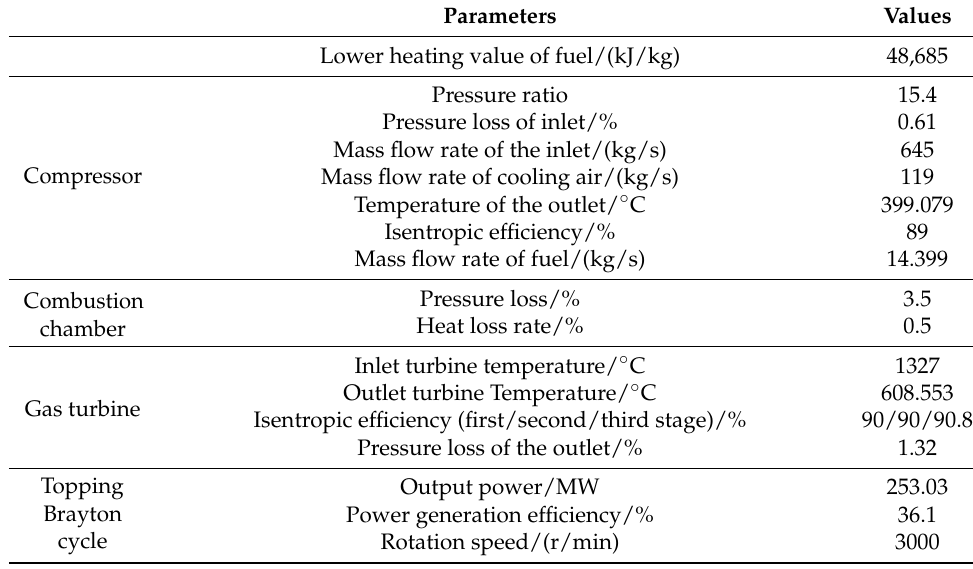
Figure 2. Flow diagram of a common gas turbine combined cycle (GTCC) system. Table 2. Design parameters of gas turbine.